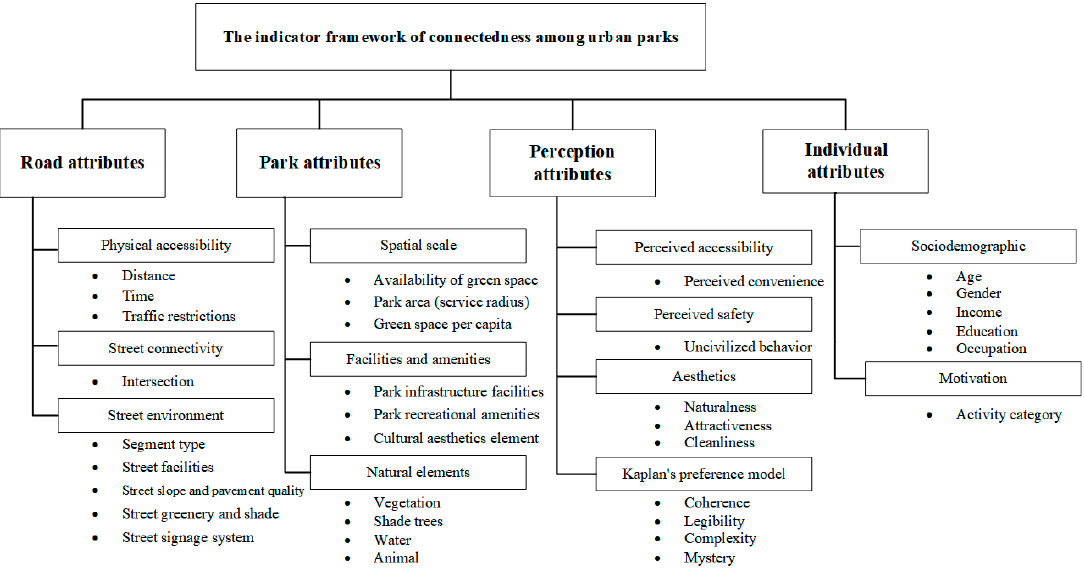
Figure 7. An indicator framework for connectedness among urban parks.